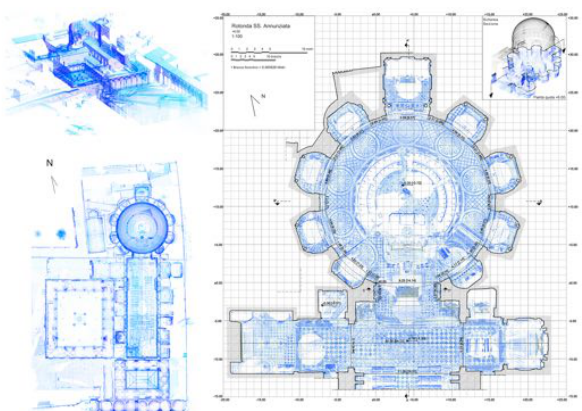
Figure 6: General plan and focus on the Tribuna of the Basilica of Santissima Annunziata in Florence, gathered from the 3D point cloud model (original drawings scale 1: 100).